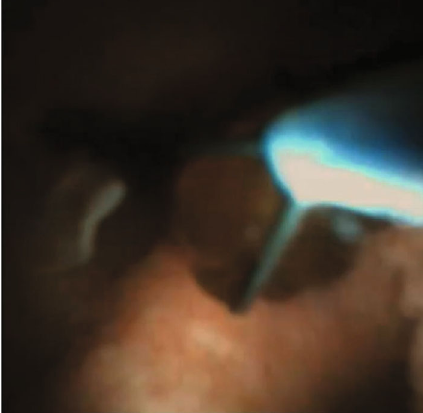
Figure 6: A fragment of calculi removed with a small caliber